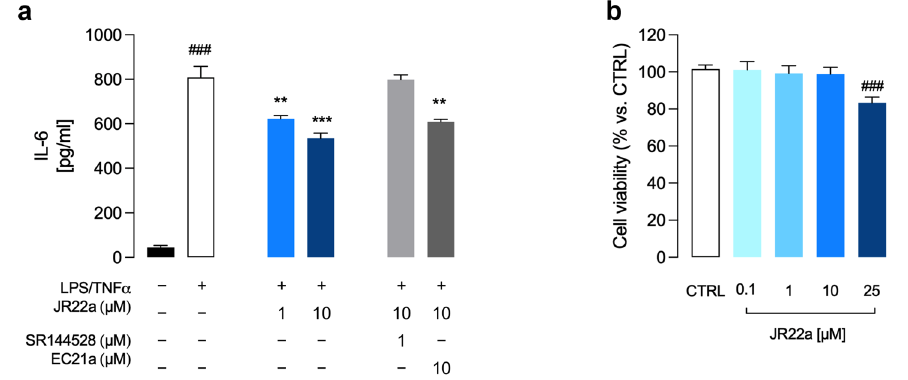
Figure 5. Effects of JR22a on the inflammatory response ( a ) and cell viability ( b ) in HMC3 cells. ( a ) Release of inflammatory IL ‐ 6 after exposure of HMC3 cells to LPS (10 μ g/mL)/TNF α (50ng/mL) stimulus for 24 h. Data represent means ± S.E.M. from n = 3 independent experiments performed in duplicate. Statistical analysis was performed by ordinary one ‐ way ANOVA followed by Tukey’s multiple comparison test. ### p < 0.005 compared to control cells; ** p < 0.01, *** p < 0.005 compared to LPS/TNF α stimulated HMC3 cells. ( b ) MTT assay was performed with different concentrations of JR22a . Data represent means ± S.E.M. from n = 3 independent experiments performed in triplicate. Statistical analysis was performed by ordinary one ‐ way ANOVA followed by Tukey’s multiple comparison test. ### p < 0.005 vs. control.